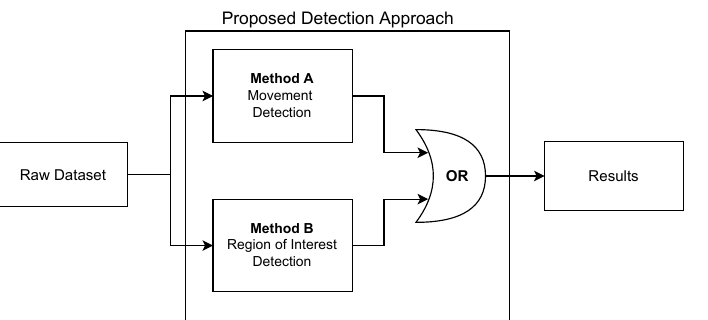
Figure 7. Proposed hybrid human-detection